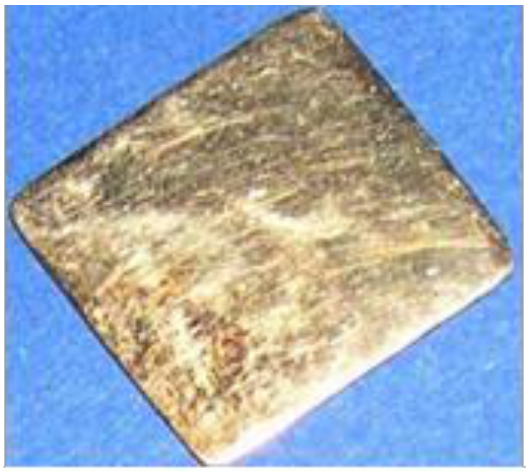
Figure 1. Ni-Cr alloy mass cracks.